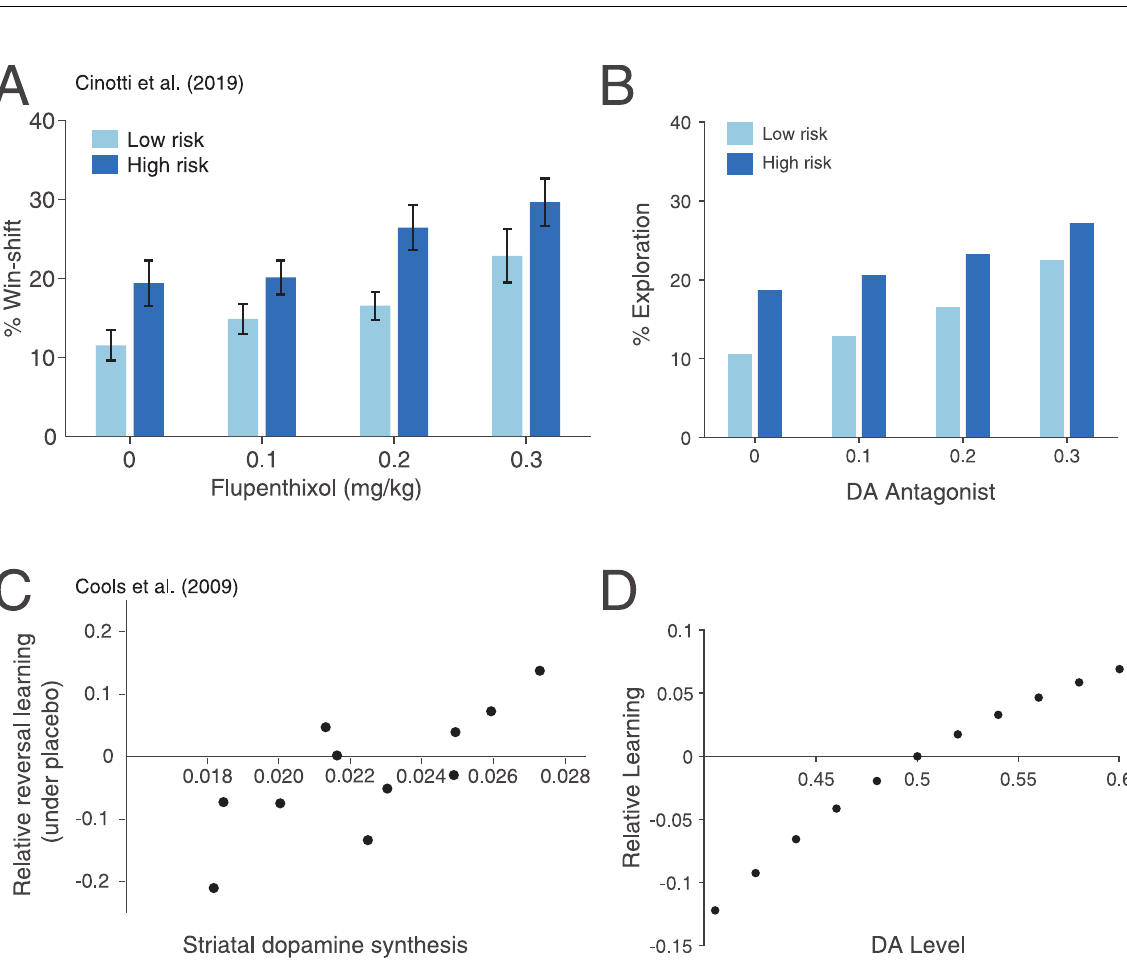
with punishment. On each trial, one of the stimuli was highlighted, and subjects had to predict